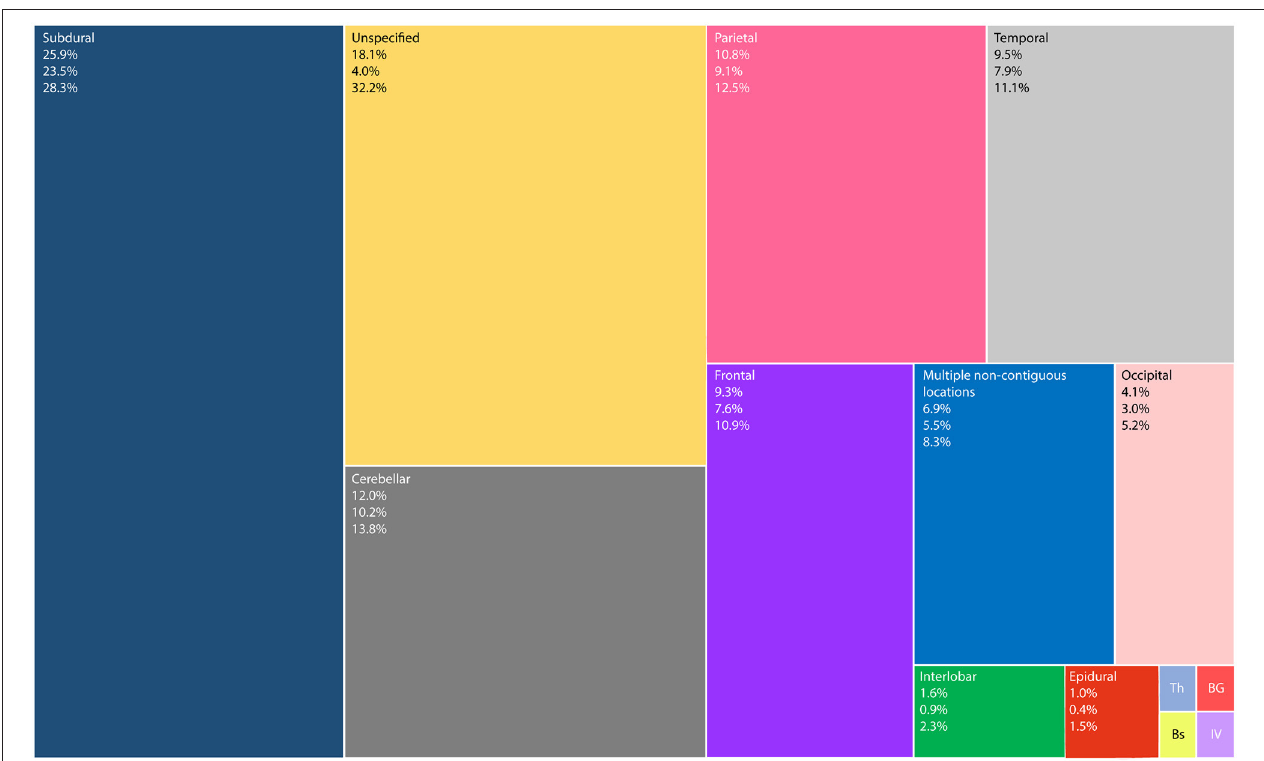
FIGURE 2 | TreeMap showing the distribution of intracranial suppurations (words at the top left corner), their mean percentage (first number), lower and upper limits of the 95% confidence interval (second and third numbers, respectively). Th—Thalamic 0.2% (95% CI = 0.0 to 0.5%); BG—Basal Ganglia 0.2% (95% CI = − 0.1 to 0.4%); Bs—Brainstem 0.2% (95% CI = − 0.1 to 0.4%); and IV—Intraventricular 0.2% (95%CI = − 0.1 to 0.4%). Unspecified corresponds to supratentorial intra-axial lesions, whose locations were not further